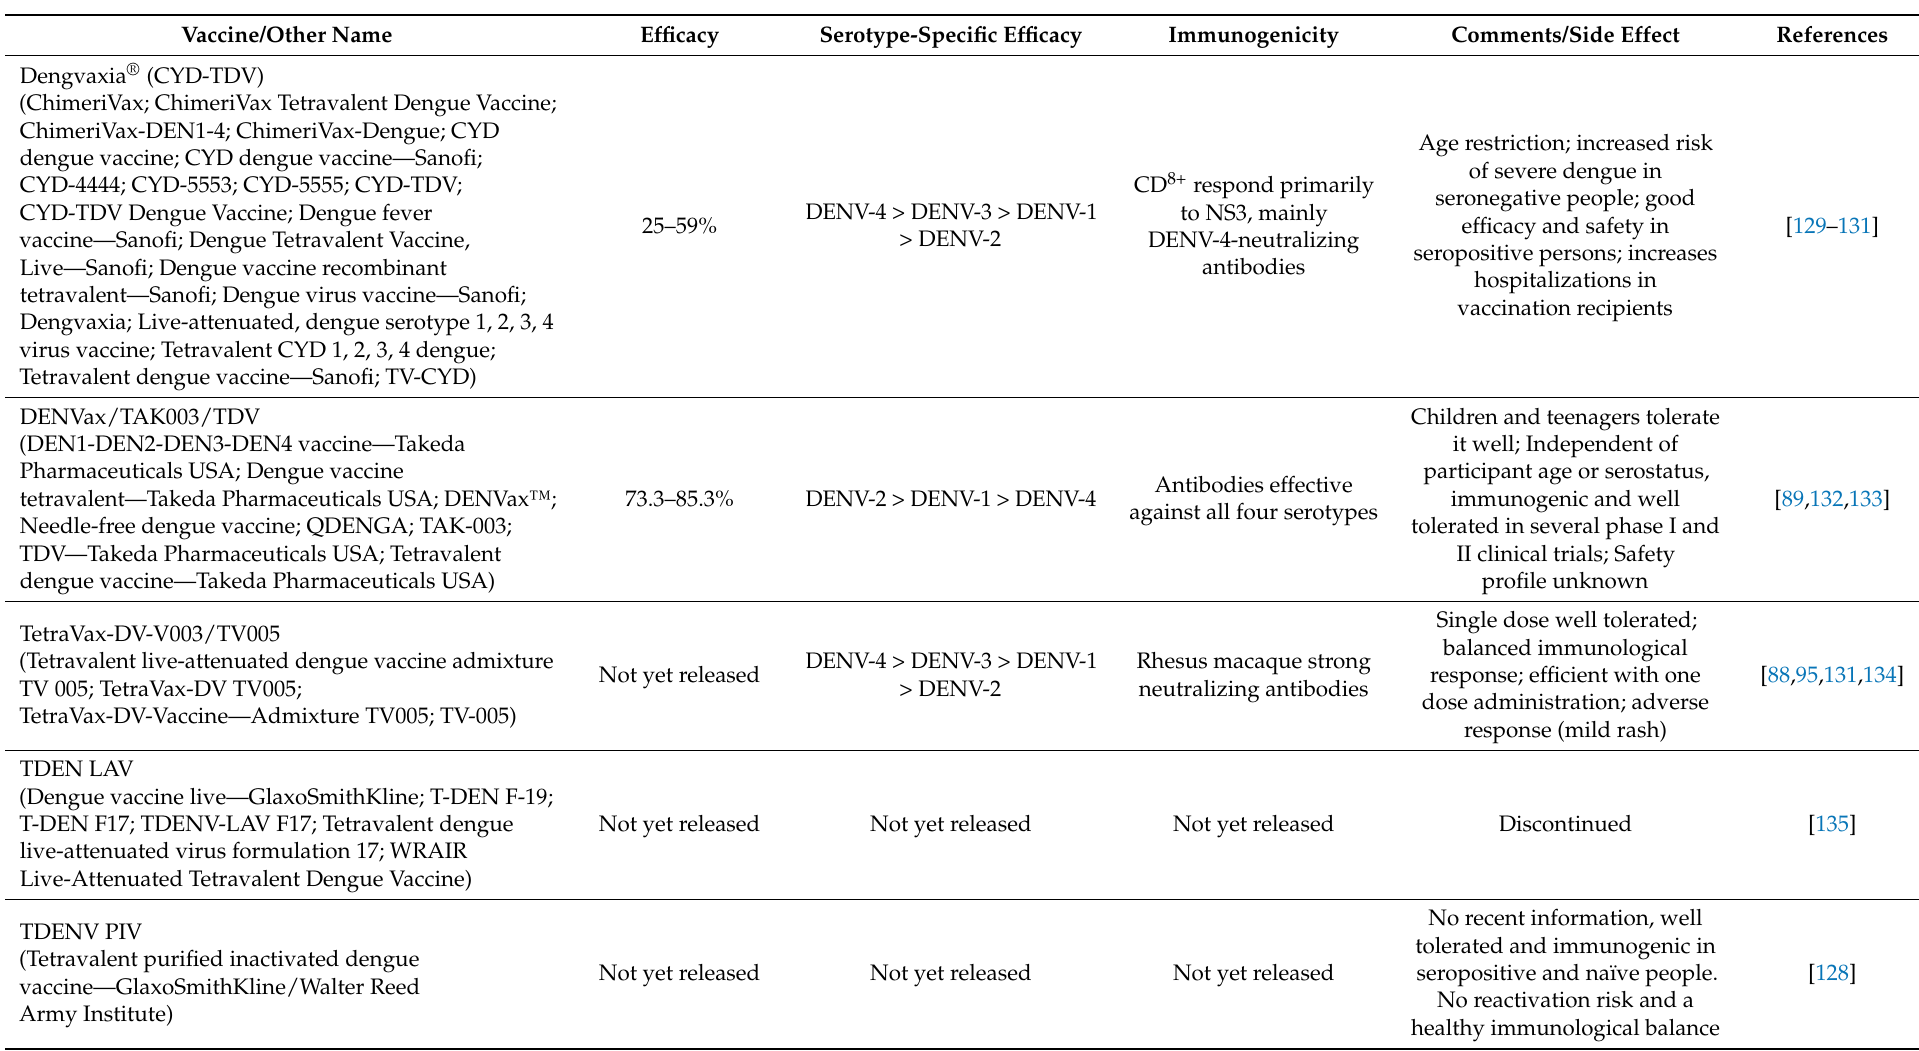
Table 3. Efficacy, immunogenicity, and side effects of some dengue vaccines in clinical